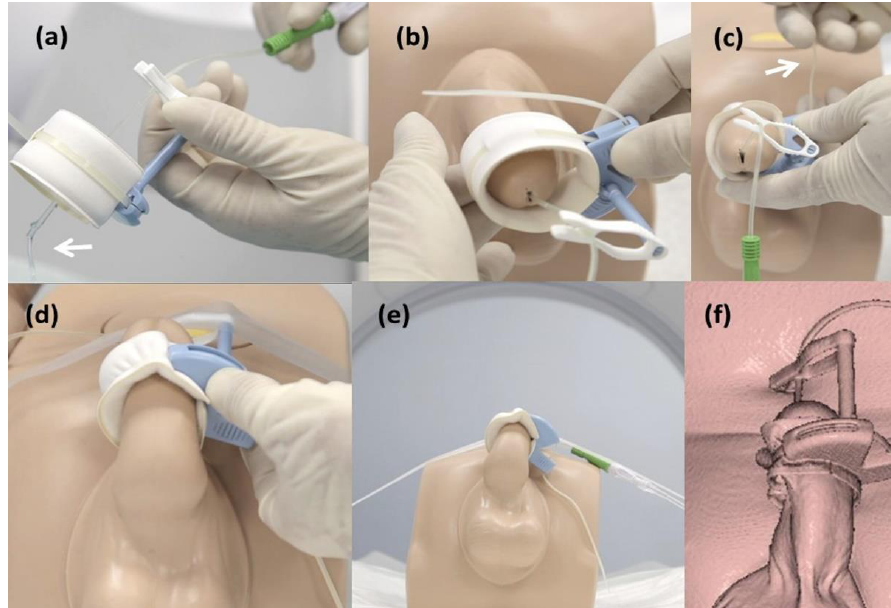
Figure 1. Description of the clamp method for Computed-Tomography (CT)-retrograde urethrography: ( a ) purging of the infusion system and catheter (arrow); ( b ) insertion of the catheter (held by the clamp) in the urethral meatus; ( c ) external compression when the band is pulled tight (arrow); ( d ) immobilisation of the penis in the infraumbilical region; ( e ) position prior to CT; ( f ) 3D CT image of one of the patients.